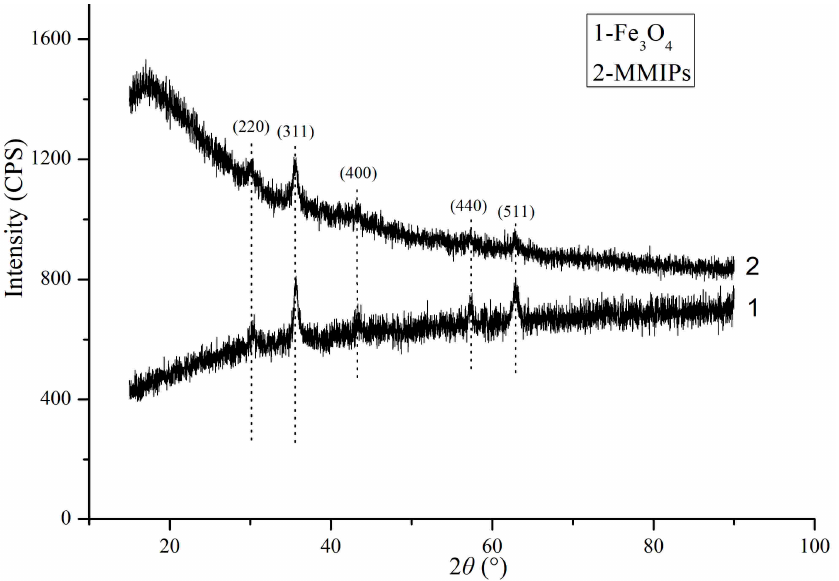
Figure 3. XRD patterns for the pure Fe 3 O 4 (1) and MMIPs (2).